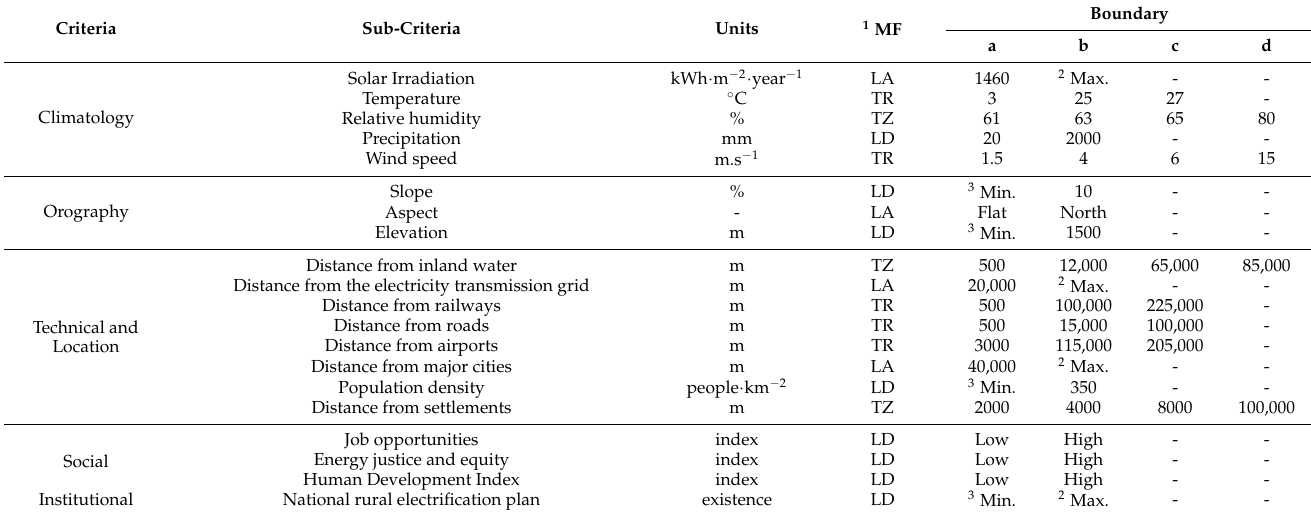
Table 6. Membership functions for each criterion standardization for Mozambique’s off-grid solar PV microgrid site